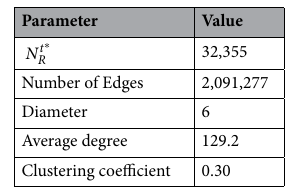
Table 2. Properties of the generated networks of the selected undirected model.